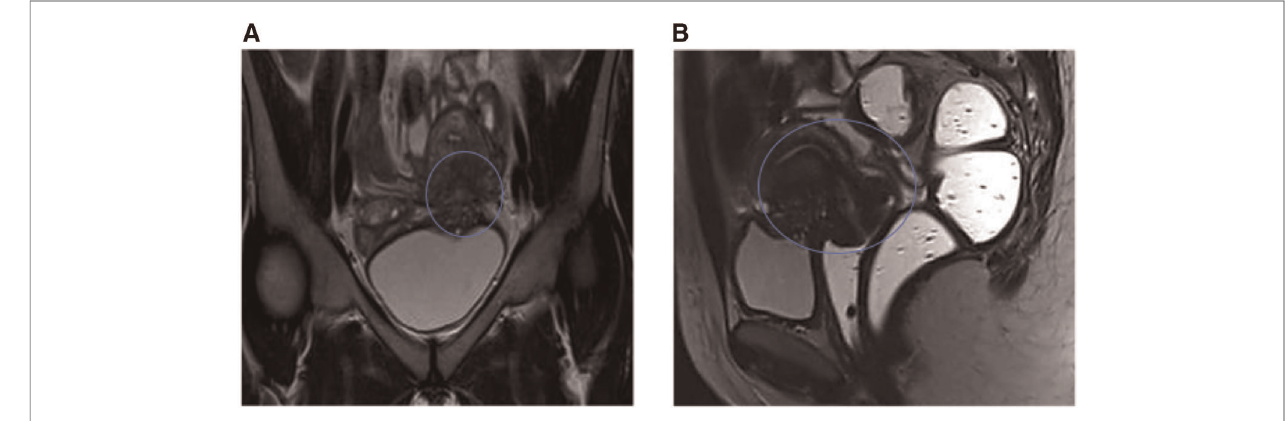
FIGURE 6 | ( A ) bladder involvement, ( B ) visceral